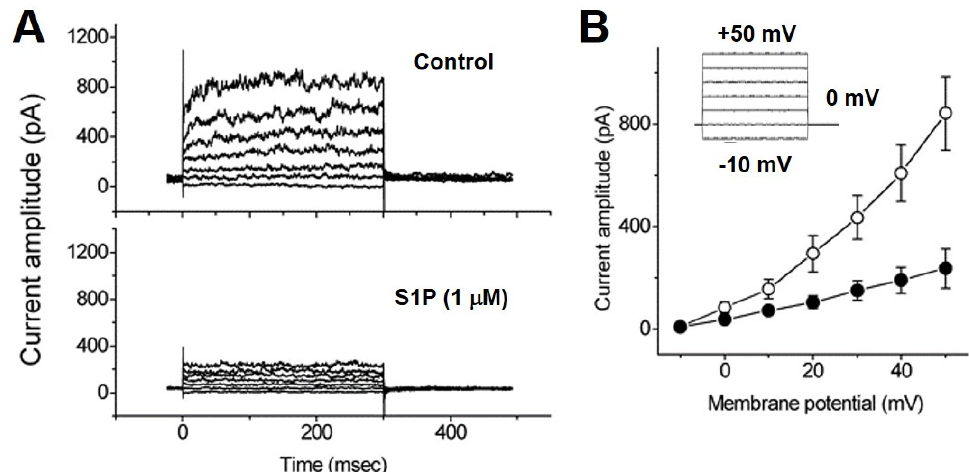
Figure 6. Inhibitory effect of S1P on I K(Ca) in PC12 cells. ( A ) Superimposed current traces obtained in the control and presence of S1P (1 µM). The cells were bathed in a normal Tyrode solution with 1.8 mM CaCl 2 , and the pipette solution containing 0.1 µM Ca 2+ . ( B ) Averaged I-V relations of current amplitudes measured at the end of voltage pulses in the absence ( ○ ) and presence ( ● ) of 1 µM S1P. Each point represents the mean ± SEM ( n = 6, in three cultures).